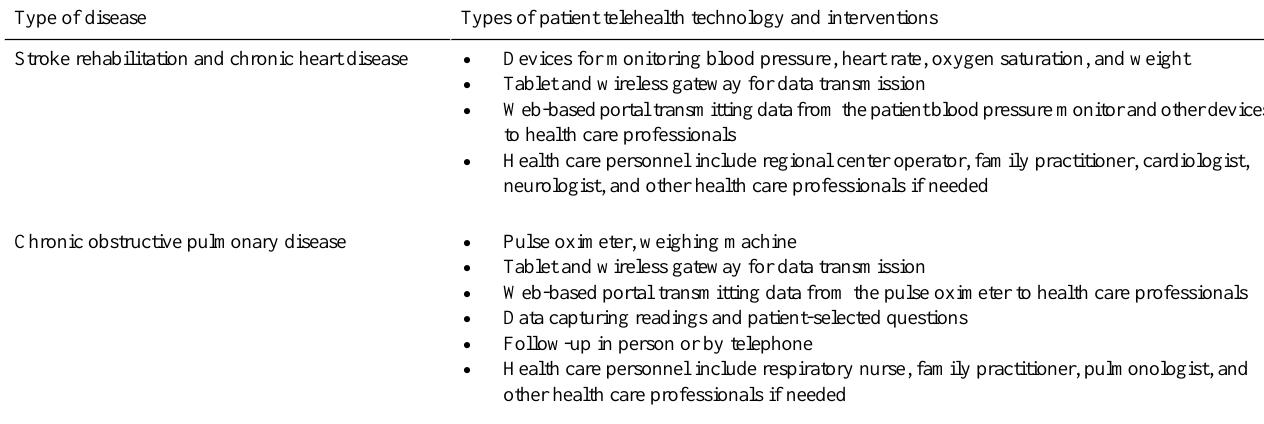
Types of patient telehealth technology and interventionsType of disease